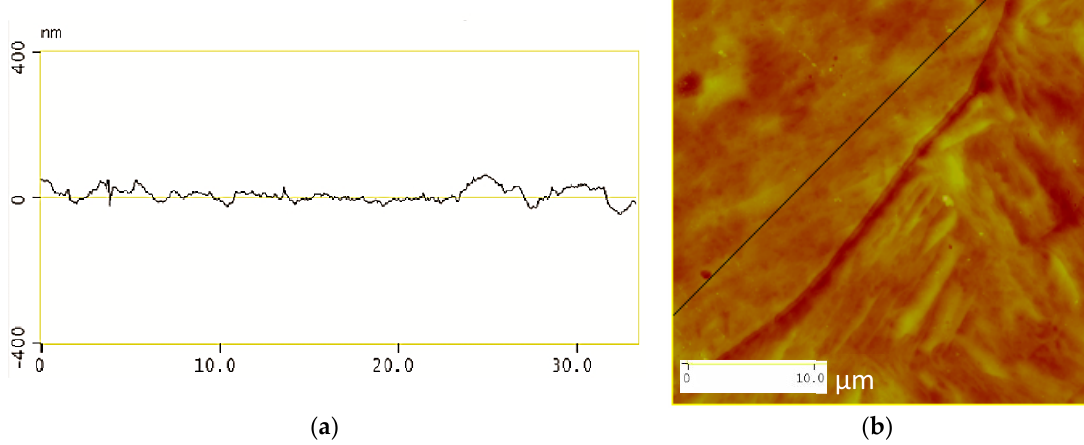
Figure 9. Surface analysis of the martensitic inner structure shown in ( a ) and the two-dimensional image shown in ( b ).